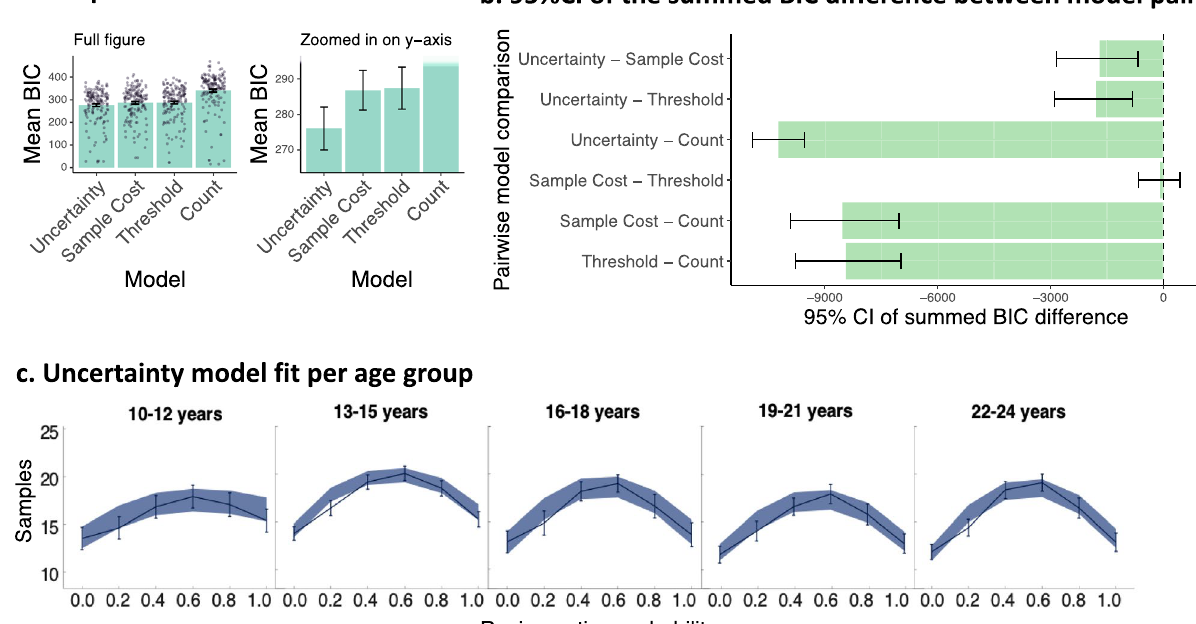
Figure 3. Model fit results. ( a ) The Bayesian Information Criterion (BIC) per model, averaged over participants (bars depict the mean and error bars show the s.e.m). Dots show individual BIC scores. Lower BIC values indicate a better fit, thus showing that the Uncertainty model fits best. BIC scores were computed for each participant and each model. The left panel is the full figure, while the panel on the right is zoomed in as the count model fitted much less well than the other models. ( b ) 95% confidence intervals (CI) of the summed BIC difference between models. Zero indicates no difference between models. Negative values are in favour of the model before the subtraction sign, as lower BIC indicates a better fit. The Uncertainty model fits significantly better than the Sample Cost and Threshold models (95% CI does not contain zero). The BIC scores of a model pair were subtracted from each other for each participant, thereby obtaining one difference score per participant for each model pair. To assess significance, the 95% confidence interval of the BIC difference was computed using bootstrapping with 10 5 iterations. ( c ) Alignment between the uncertainty model predictions and behavioural data across age. Age is grouped for visualization purposes. The shaded area is the s.e.m. of the data that was simulated with the participants’ estimated parameters in the Uncertainty model. The line graph represents the mean and s.e.m. of the participants’ actual data. The overlap between the shaded area and line graphs show that the Uncertainty model fitted well for each age